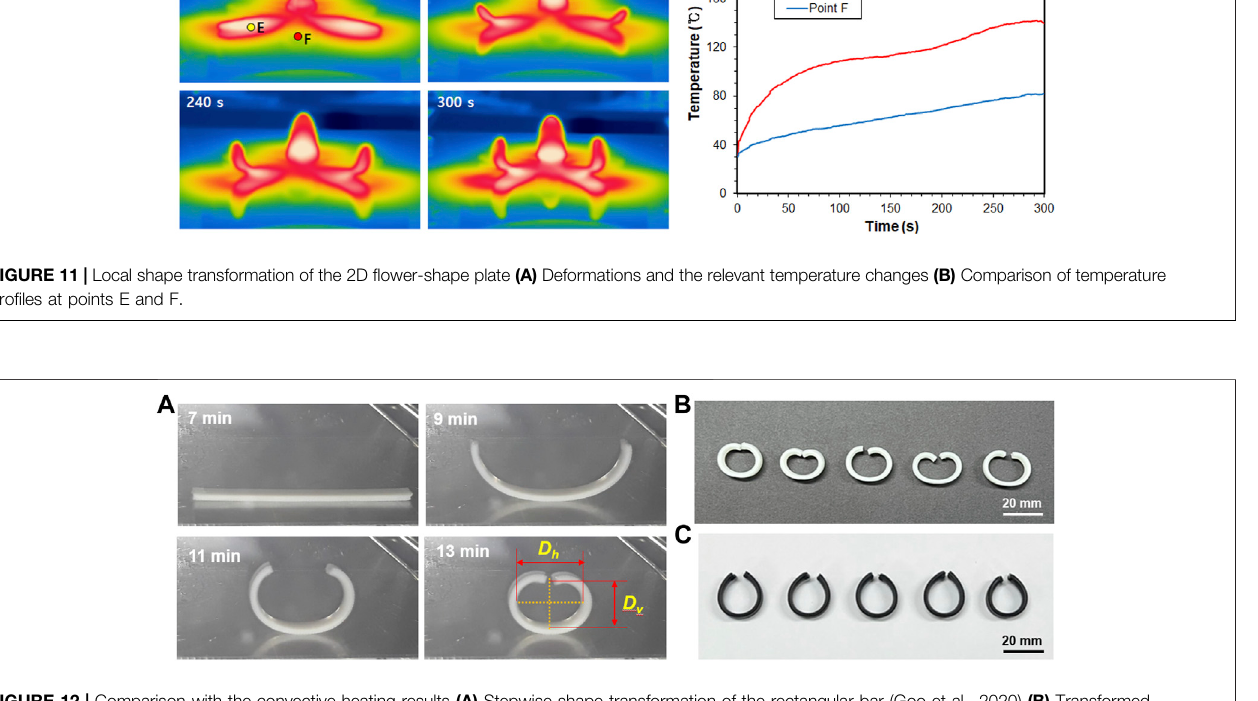
Frontiers in Materials |